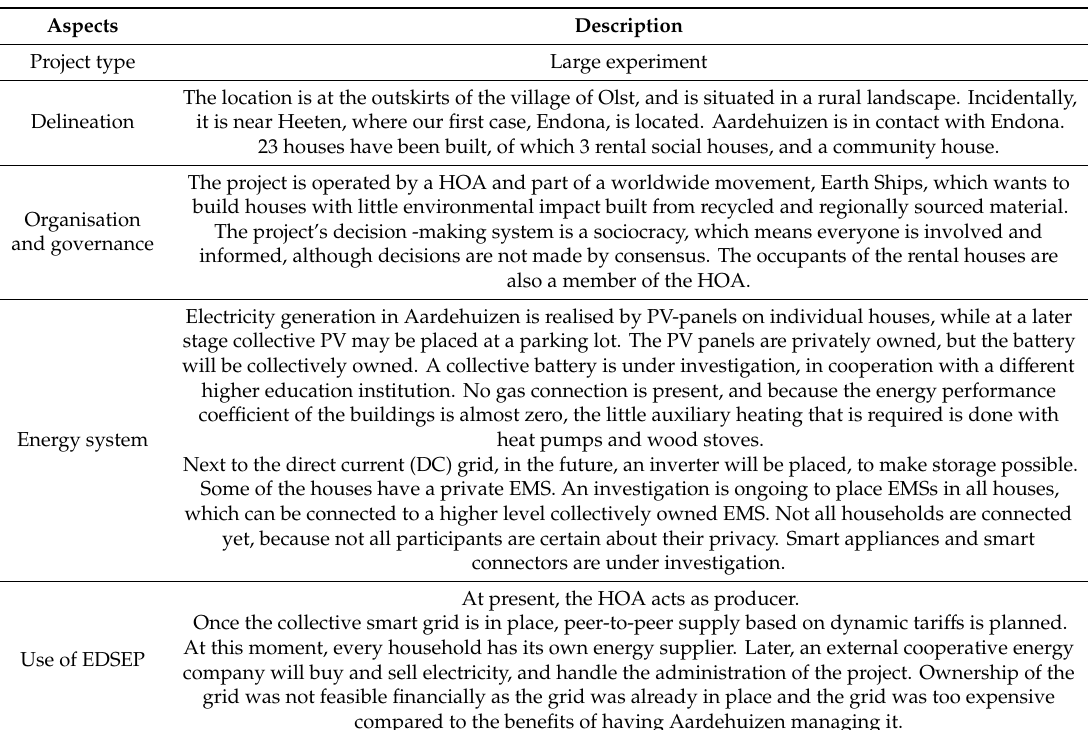
Table 4. Case study description